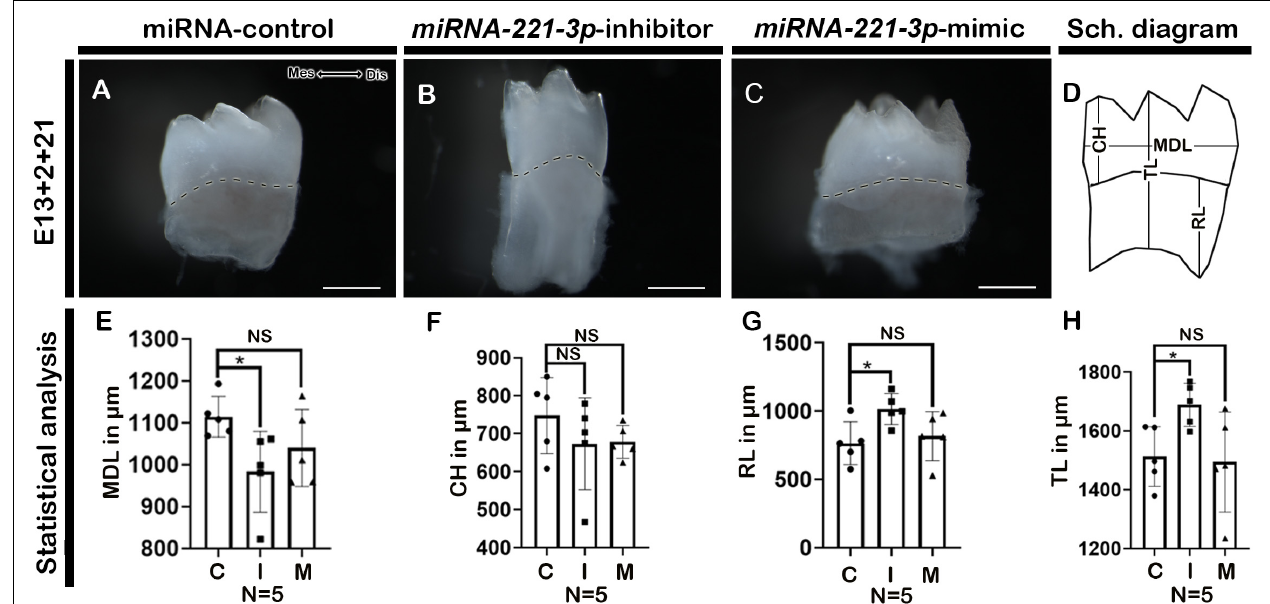
FIGURE 5 | Altered tooth morphology in 3-week renal calcified teeth. Three weeks renal calcified teeth showing buccal view (A–C) . Schematic diagram showing MDL, CH, RL, and TL of renal calcified teeth (D) . Statistical analysis showing MDL, CH, RL, and TL of 3-week renal calcified tooth ( E–H , n = 5). Inhibition of miRNA-221-3p makes tooth longer and slenderer compared to control and mimic (A–C) . The mesio-distal length is significantly shorter, while root length is significantly longer in the inhibitor-treated specimen (B,E,G) . The dotted lines demarcate the boundary of crown and root (A–C). MDL, mesio-distal length; CH, crown height; RL, root length; TL, total length; Mes, mesial; Dis, distal. Data were evaluated for statistical significance using unpaired, two-tailed t -test. ∗ Indicates p < 0.05; NS, not significant. Scale bars: 500 µ m (A–C) .